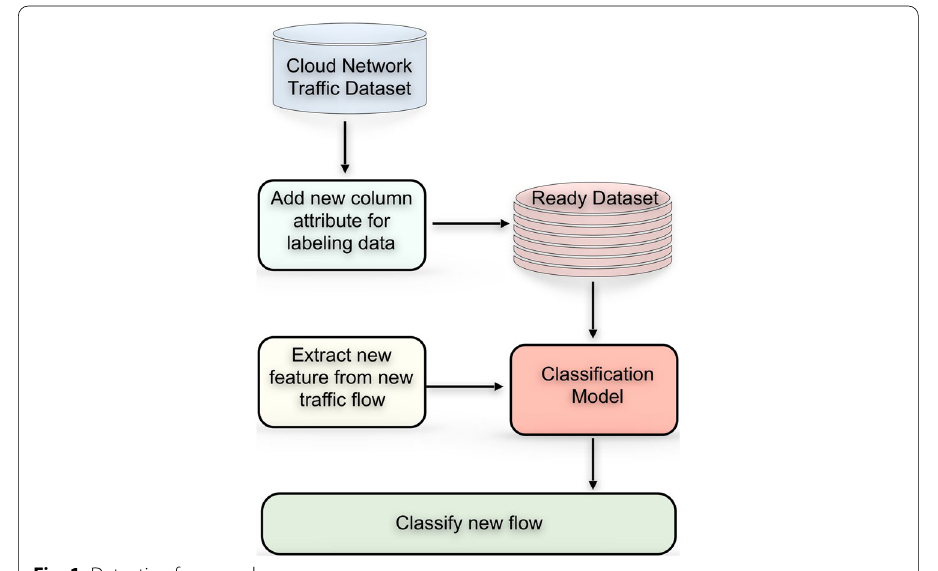
Fig. 1 Detection